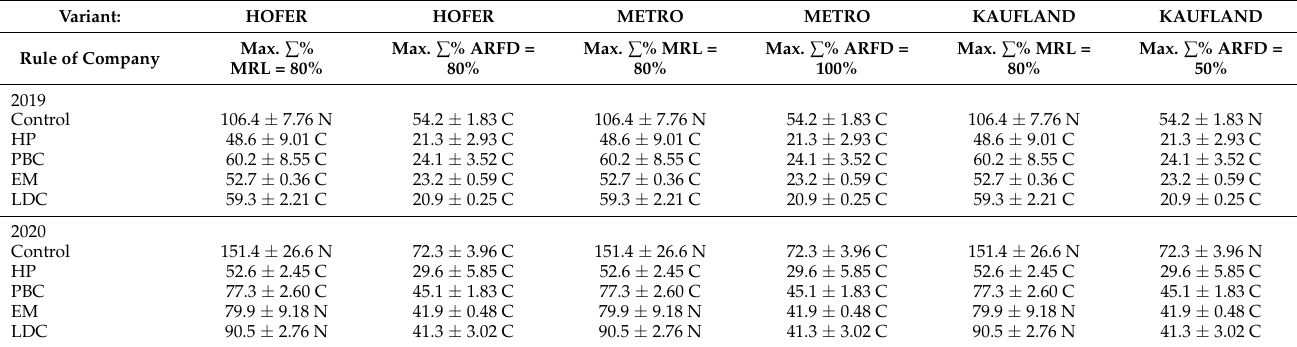
Table 7. Information about the compliance of apples produced under different spray regimes, considering the rules of three supermarket chains. Mark C means that the apples comply with the upper limit of the parameter’s value, and mark N means that the apples do not comply with the